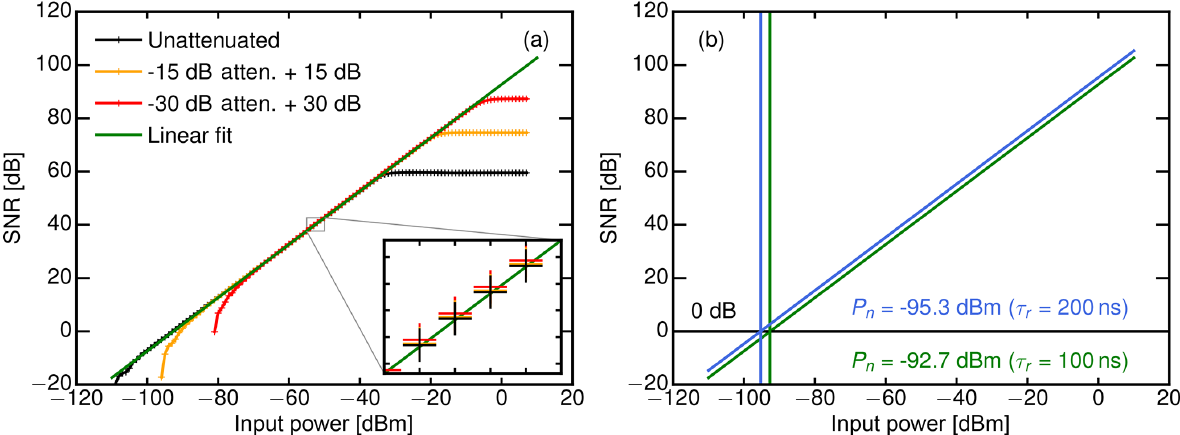
Figure 4. (a) Measured receiver transfer functions for the three attenuator settings of 0dB (black), 15dB (green) and 30dB (red). (b) Linear regression receiver transfer function to determine the receiver sensitivity P n